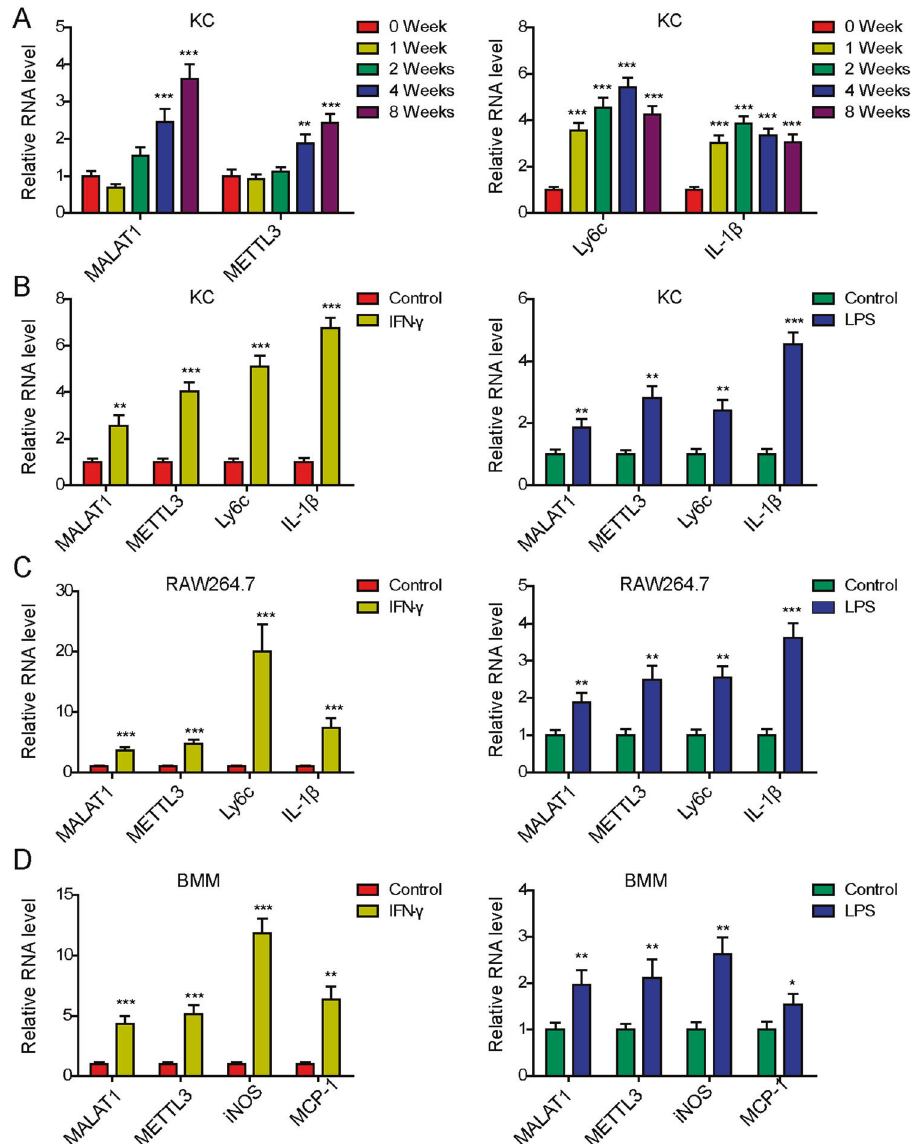
Fig. 1 MALAT1 and METTL3 were up-regulated in Kupffer cells (KCs) during liver fi brosis, and in M1 macrophages activated with IFN- γ or LPS. Mice were treated with CCl4 to induce liver fi brosis. A Expressions of MALAT1, METTL3, Ly6c, and IL-1 β were examined by RT-PCR in KCs isolated from mice treated with CCl4 for 0, 1, 2, 4, and 8 weeks, respectively. KCs ( B ), RAW264.7 ( C ), and BMMs ( D ) were stimulated with either IFN- γ or LPS for 24 h and expressions of indicated genes were measured by RT-PCR. * P < 0.05, ** P < 0.01, *** P <